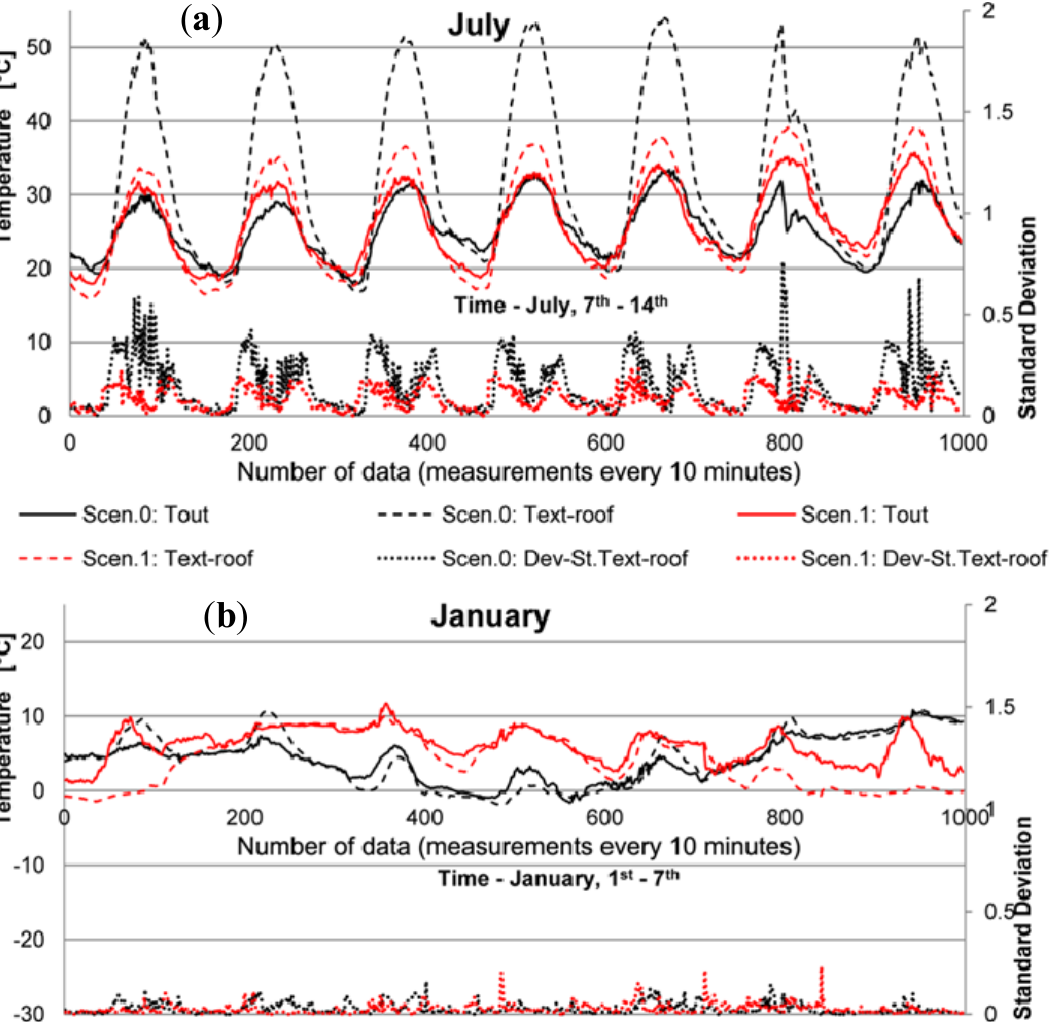
Figure 5. Weekly trends of external temperature, surface roof temperature and standard deviation in July ( a ) and January ( b